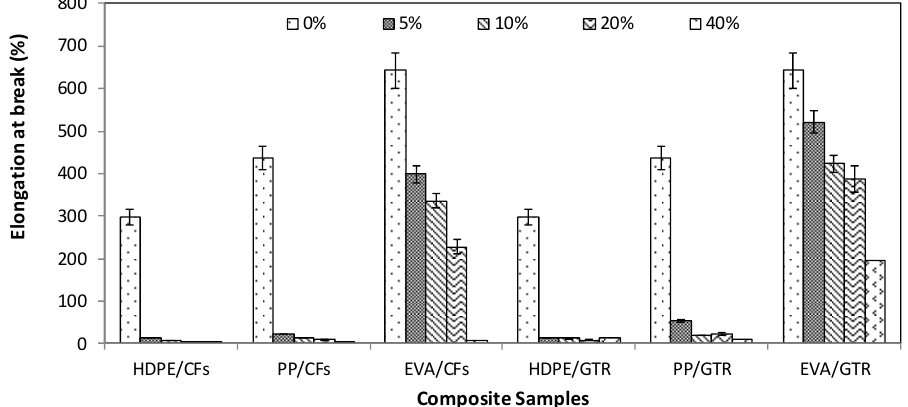
Figure 2. Young’s Modulus of the polymeric composites at compositions between 0 and 40% w / w .